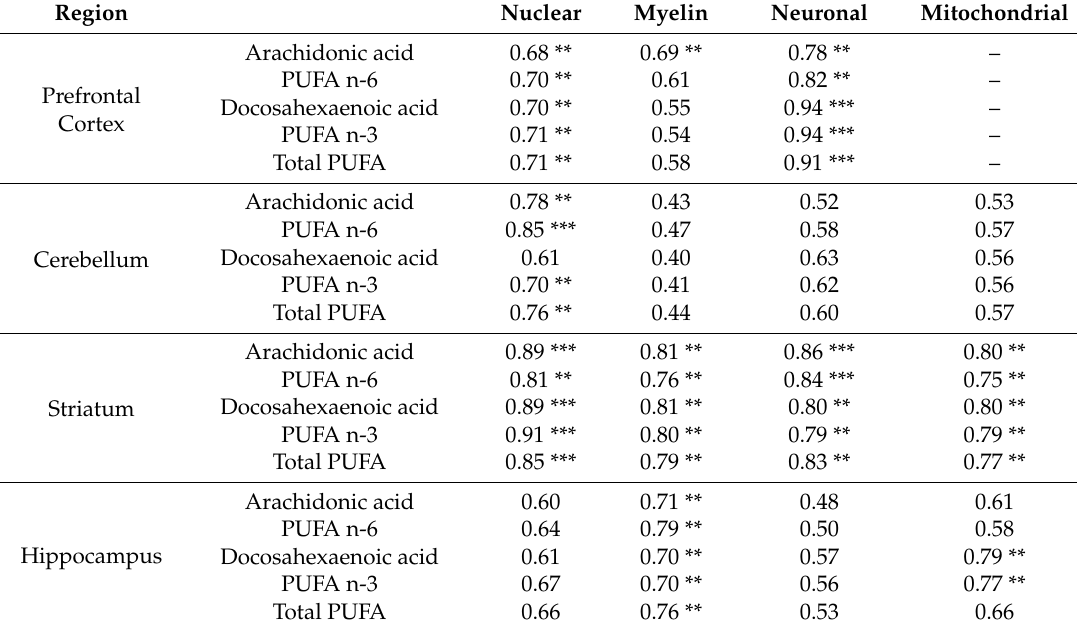
Table 3. Partial correlations between membrane α -tocopherol (ng/mg protein) and PUFA concentrations ( µ g/mg protein) from different brain regions of rhesus macaques ( n = 9).